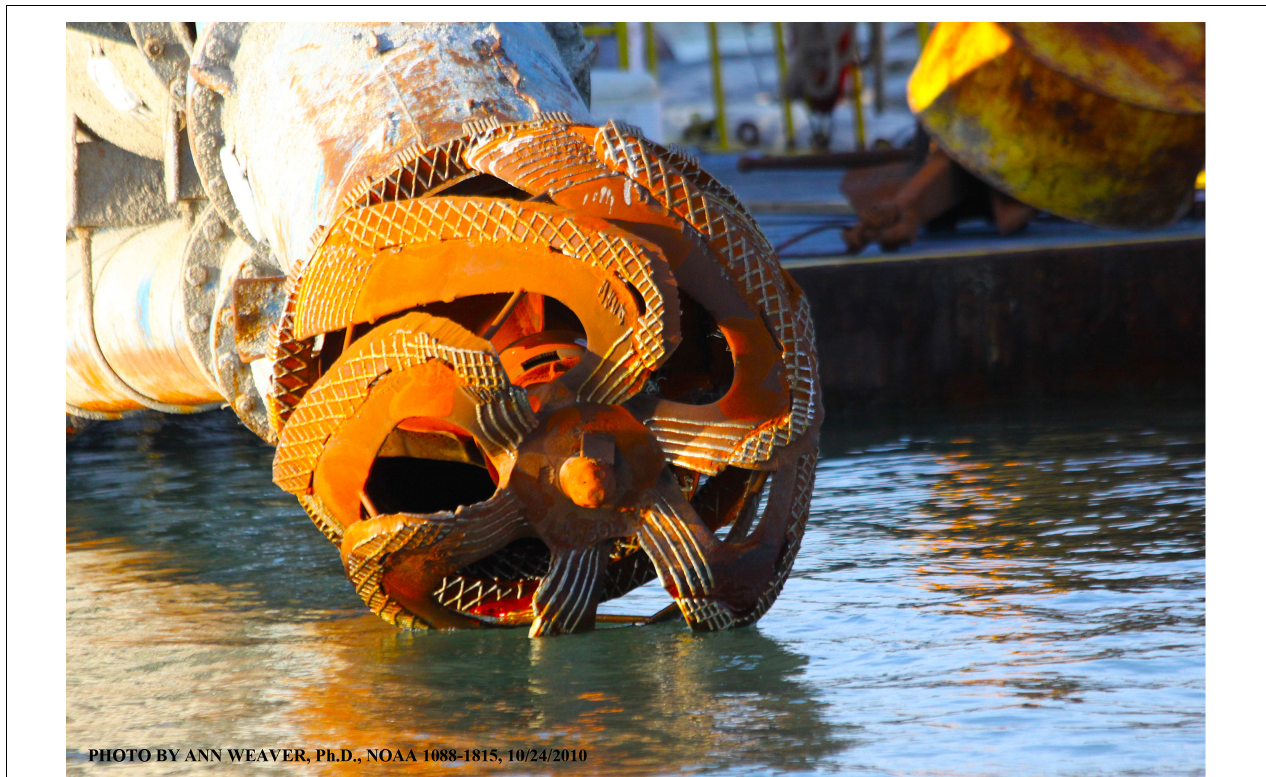
FIGURE 6 | The construction site experienced regular percussive pile driving, bored pile driving, and extensive dredging across construction. This is a photo of a dredging bit, used to churn up the seafloor and suck substrate into a pipe for delivery onto a barge for off-site dumping.